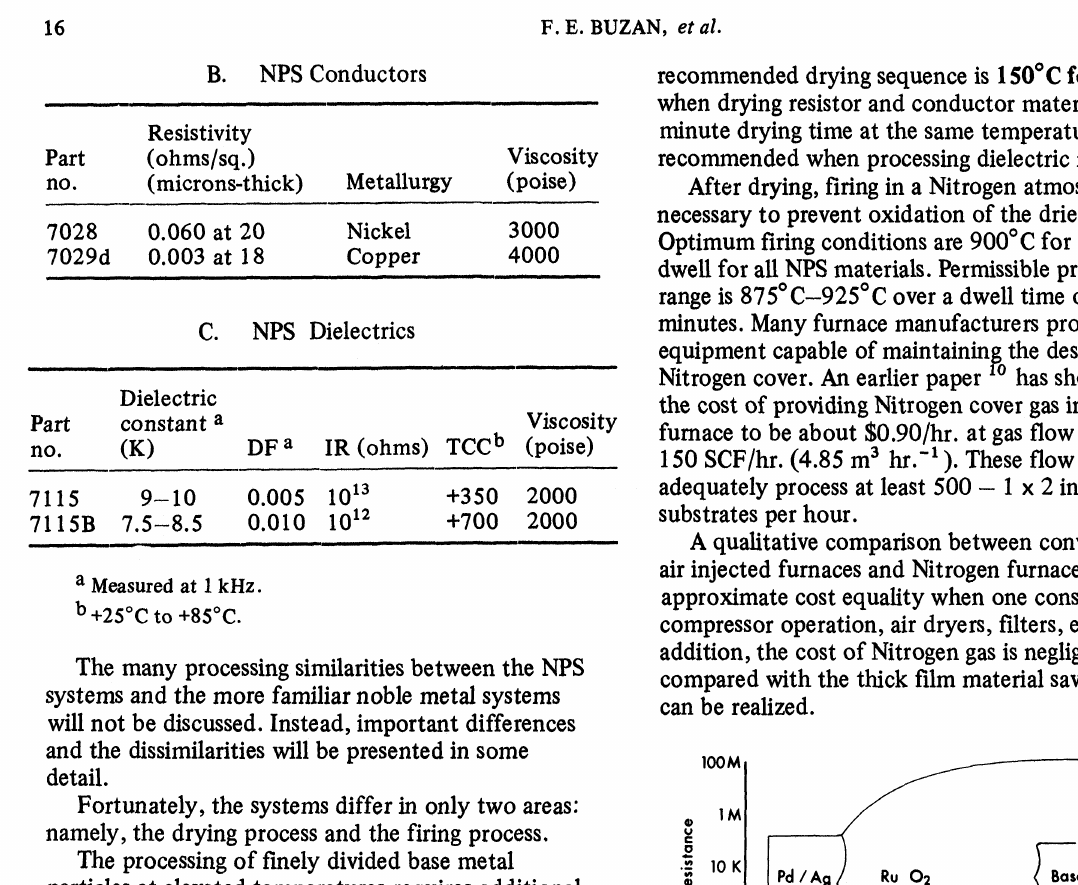
Chronological development of materials for thick film resistor compositions.